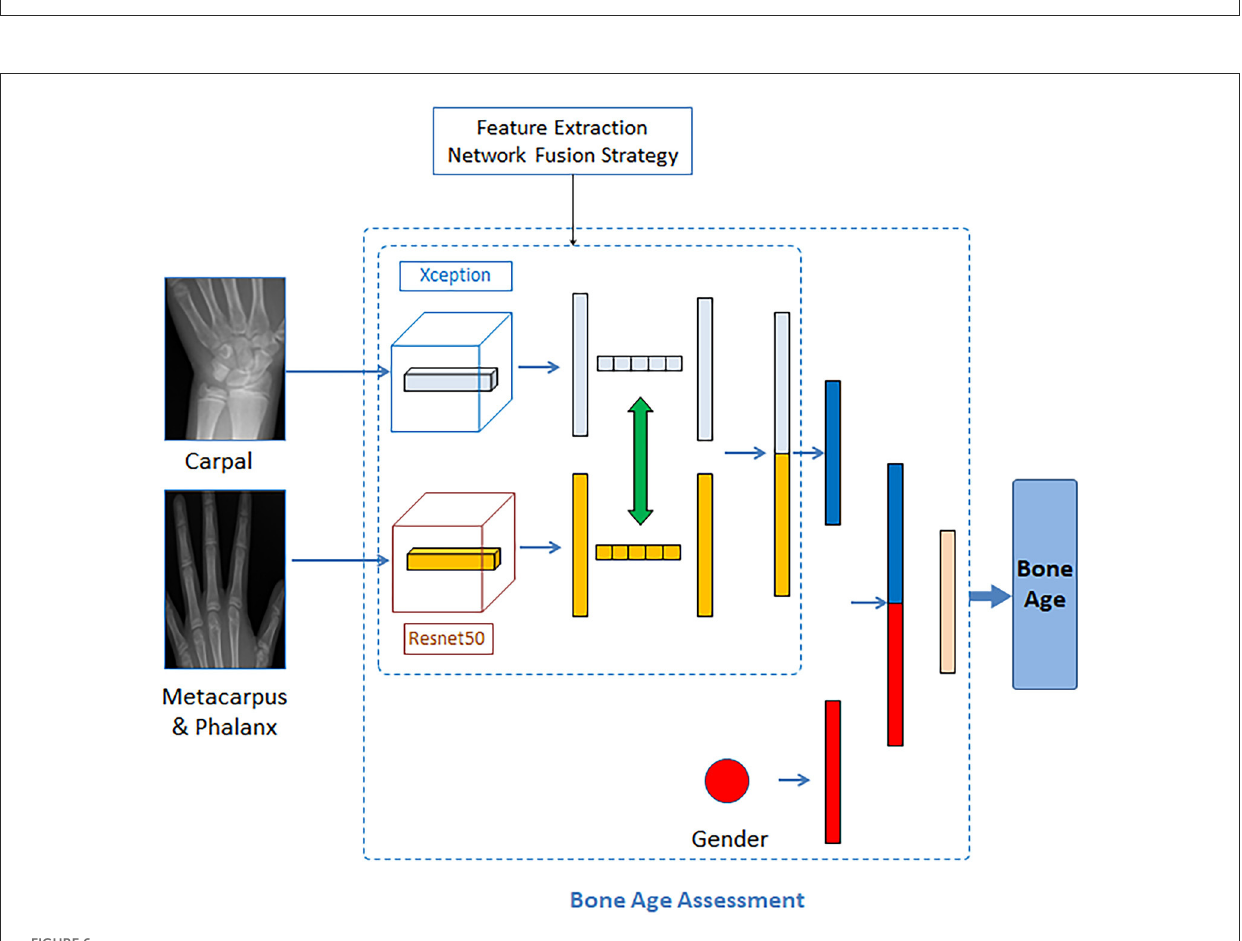
FIGURE6 Bone age assessment